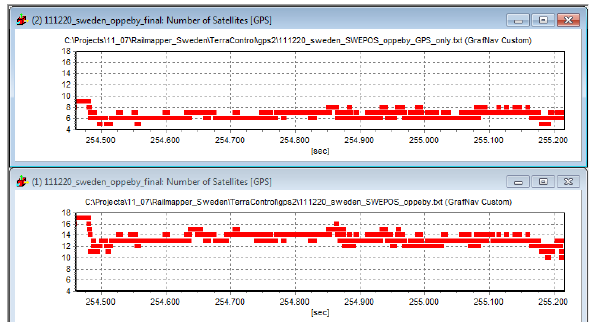
Figure 5: Comparison of the number of satellites in view.